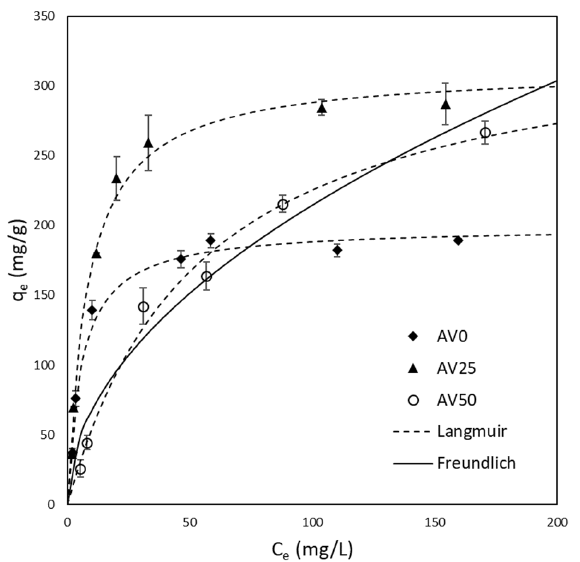
Figure 4. Isotherms at 20 °C for AV0, AV25, and AV50 fitted with Langmuir model. Only for AV50 was the fitting provided with the Freundlich model. Table 1. Langmuir and Freundlich isotherm parameters at 20 °C for AV0, AV25, and AV50.